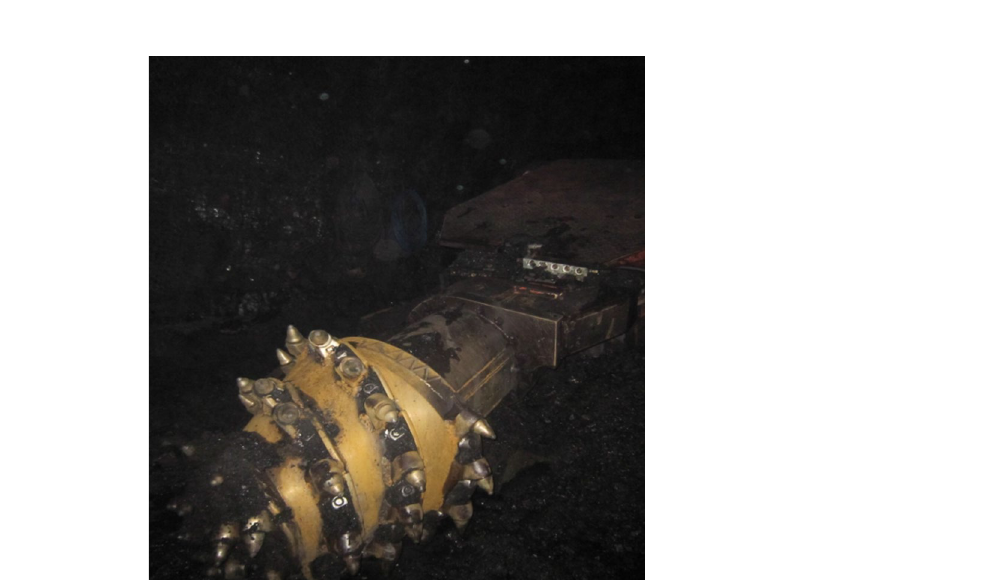
Figure 19. Cutting head of EBZ220 roadheader in underground